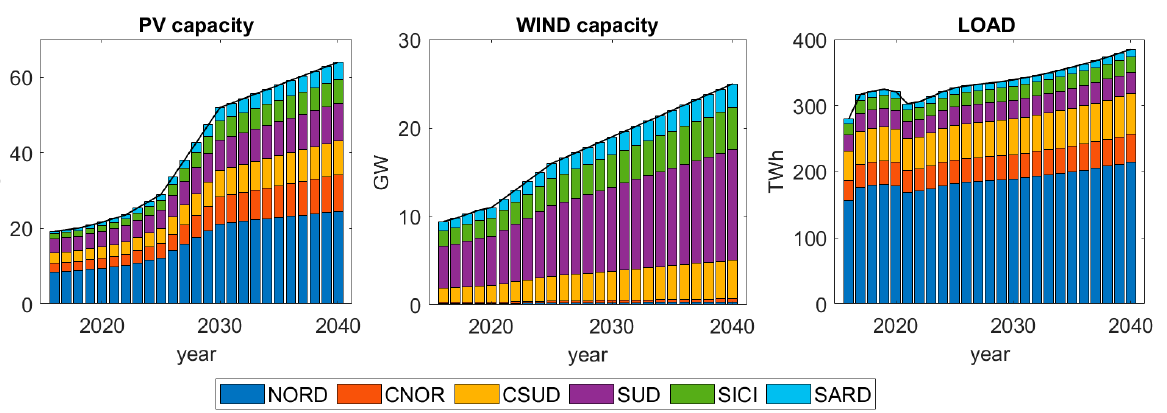
Figure 2. Load and VRE capacity growth NT-Italy scenarios developed by the Italian TSO